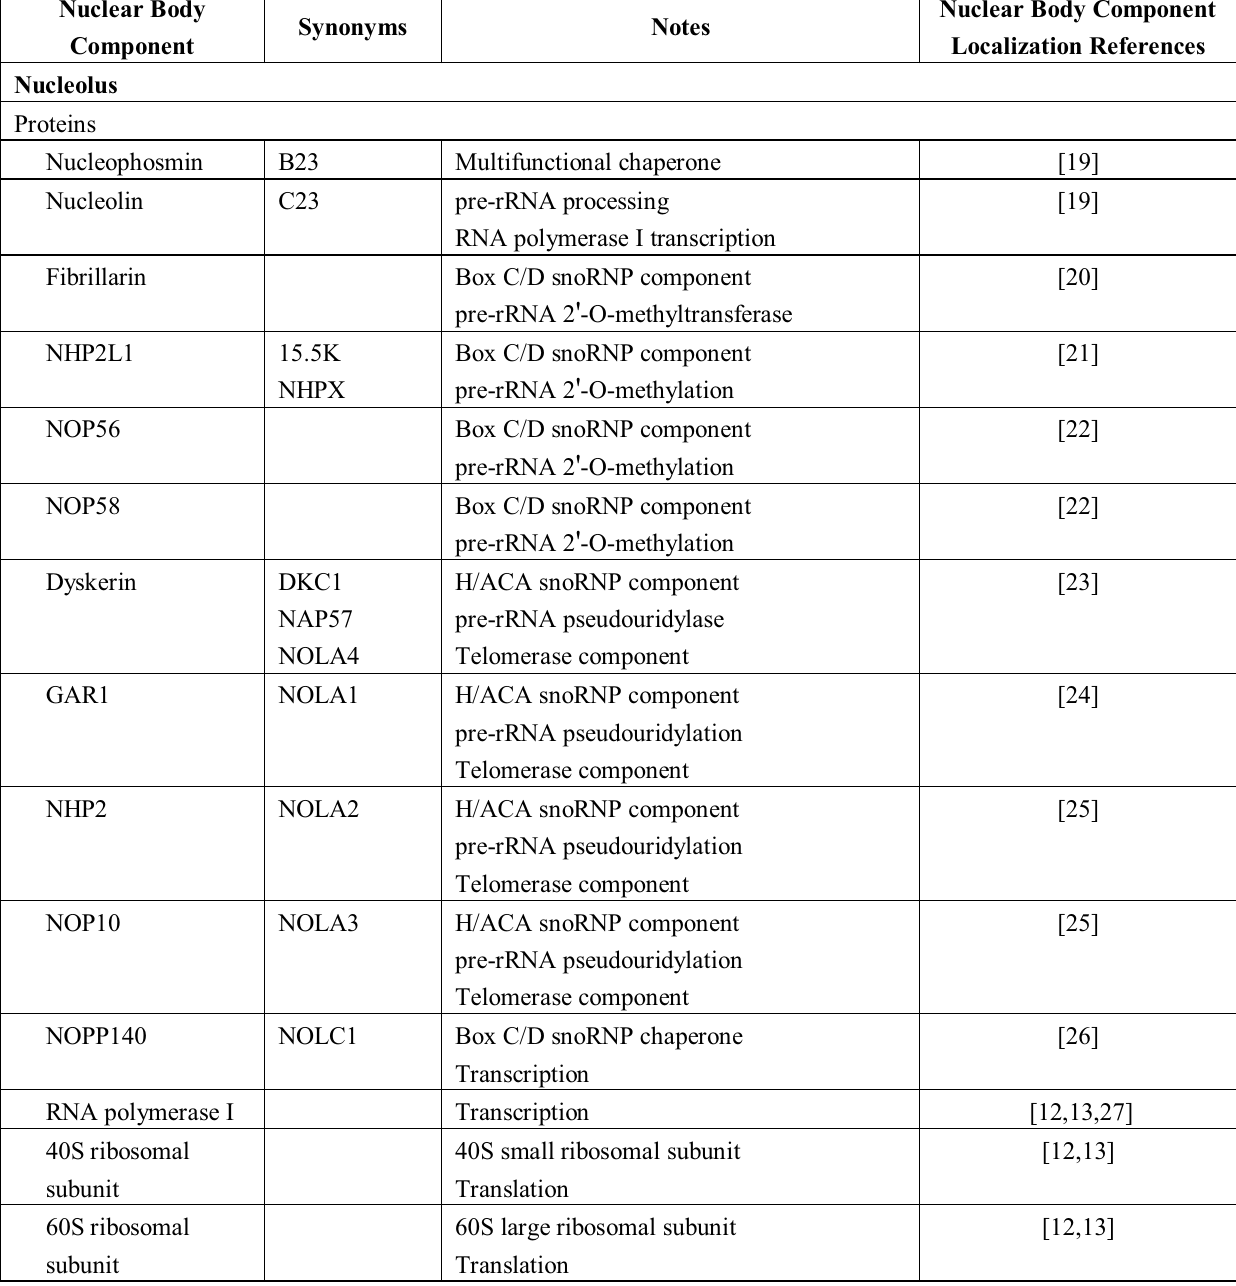
Table 1. Summary of the key components of nuclear